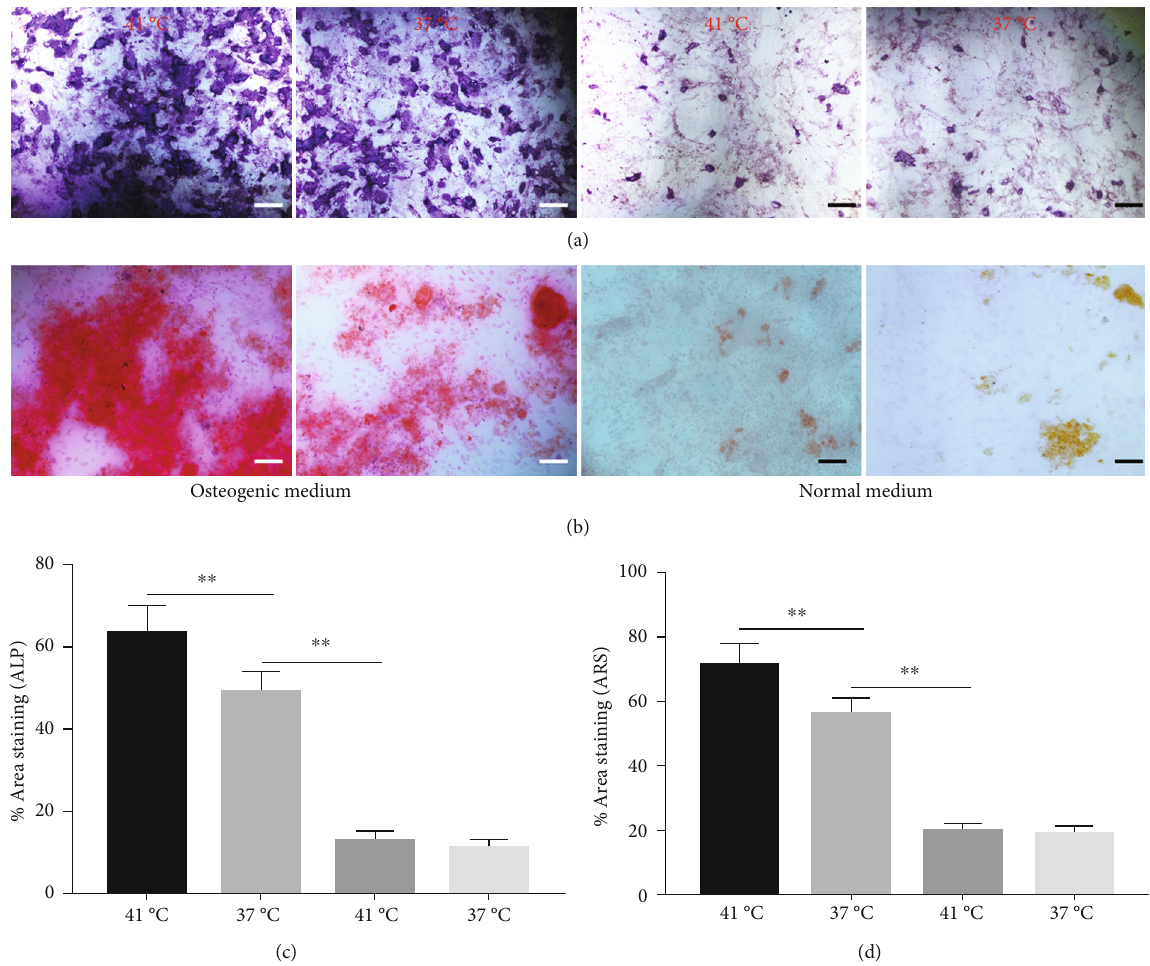
Figure 5: Heat stress promotes the osteogenesis of EMSCs. (a, b) ALP and ARS staining of EMSC cultures after 14 days of di ff erentiation induction in osteogenic medium or normal medium. (c, d) Densitometry analysis of the relative ALP activity and mineralized nodules in the images. ∗ P < 0 : 05 and ∗∗ P < 0 : 01